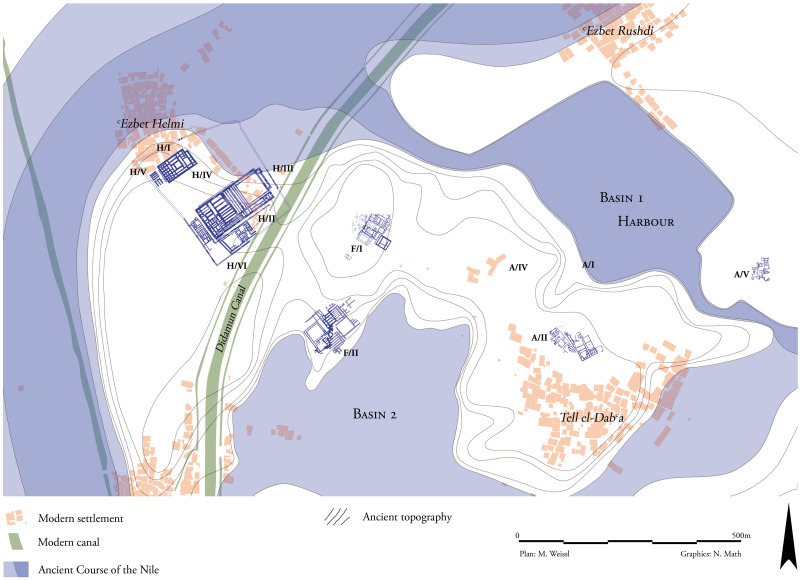
Site plan of Tell el-Dabca and nearby sites of ʿEzbet Helmi and ʿEzbet Rushdi.